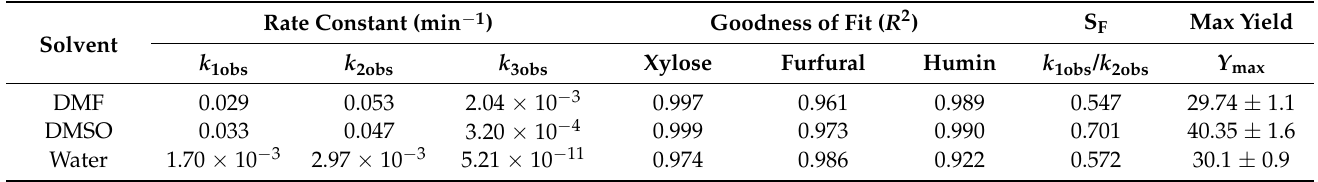
Table 1. Fitted reaction parameters for xylose conversion into furfural in different solvent mediums. Reaction